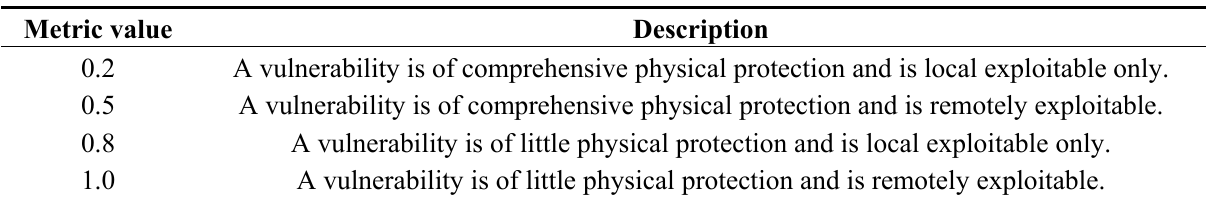
Table 1. Access Difficulty Scoring